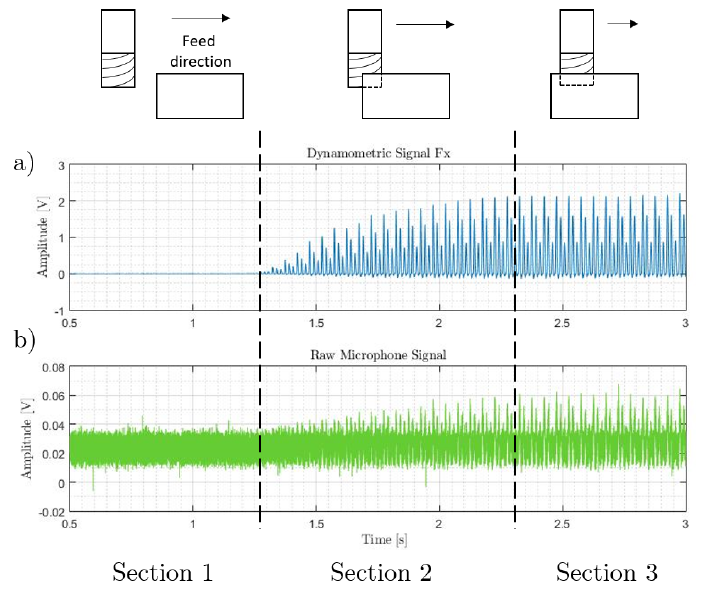
Figure 2. Phases of the end-milling process. ( a ) Cutting force signal, and ( b ) acoustic emission (AE)